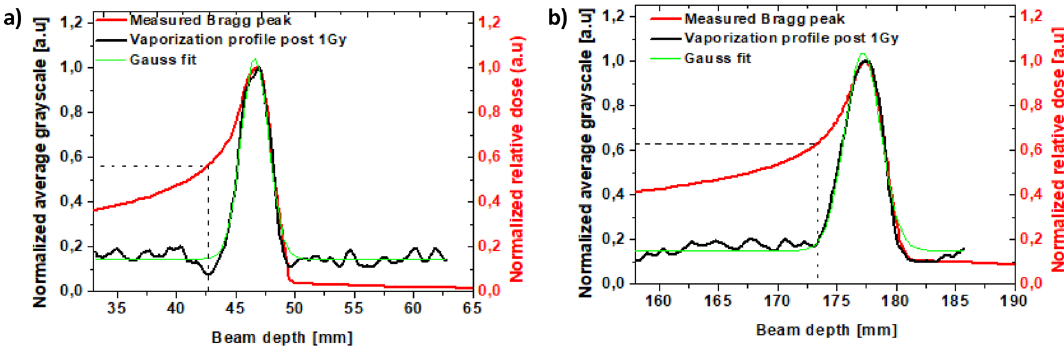
Figure 6. Overlay of the PVA/PFB NDs vaporization profile post 1 Gy C-ions exposure @37 °C and the measured Bragg curve: ( a) for a beam range of 50 mm and ( b) for a beam range of 180